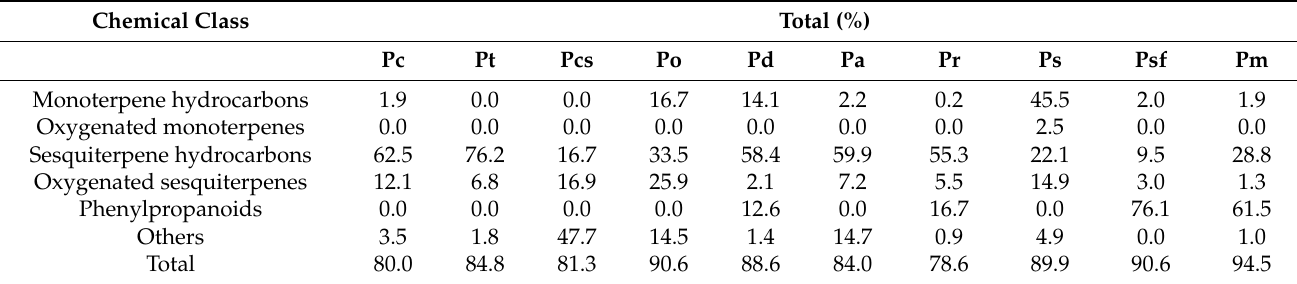
Table 2. Overall composition (percent by chemical class) of the essential oils from Piper coruscans (Pc), P. tuberculatum (Pt), P. casapiense (Pcs), P. obliquum (Po), P. dumosum (Pd), P. anonifolium (Pa), P. reticulatum (Pr), P. soledadense (Ps), P. sancti-felicis (Psf), and P. mituense (Pm).